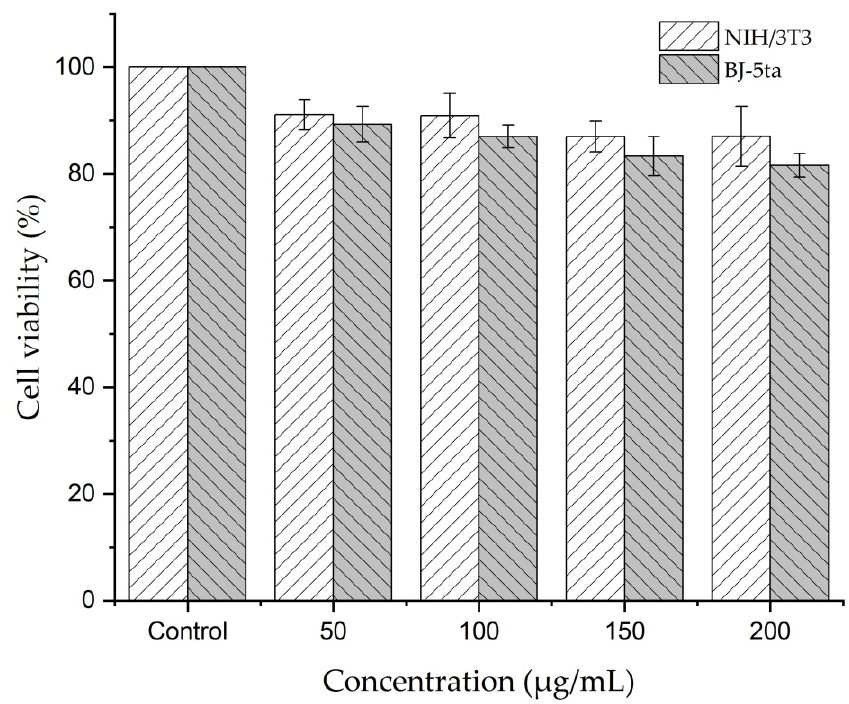
Figure 13. Cell viability of NIH/3T3 and BJ-5ta treated with GNS.